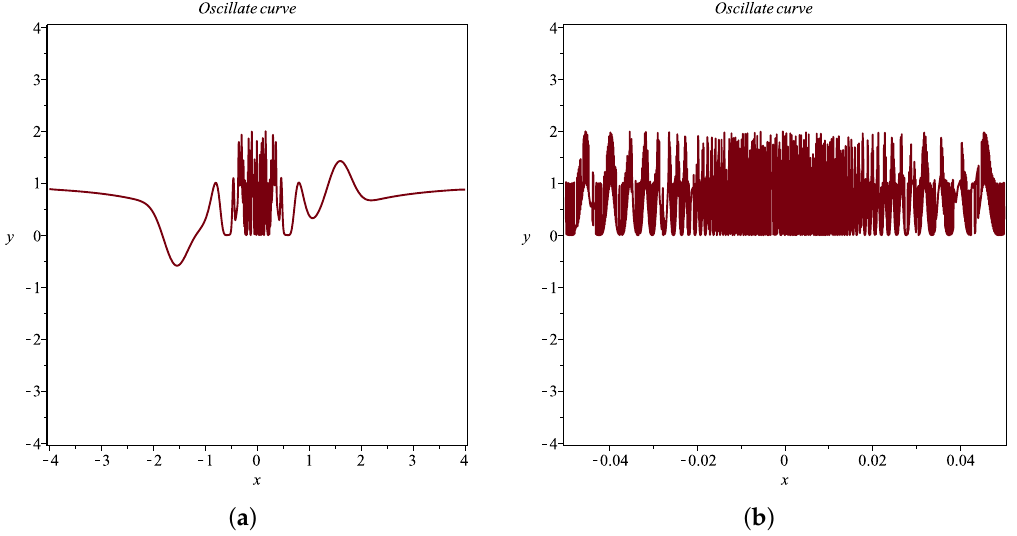
Figure 8. Oscillatory graphic display of the oscillate curve. ( a ) The entire graphic display of the oscillatory curve at the x-coordinate in the interval [ − 4,4 ] ; ( b ) The graphic zoom display of the oscillatory curve at the x-coordinate in the interval [ − 0.05, − 0.05 ]